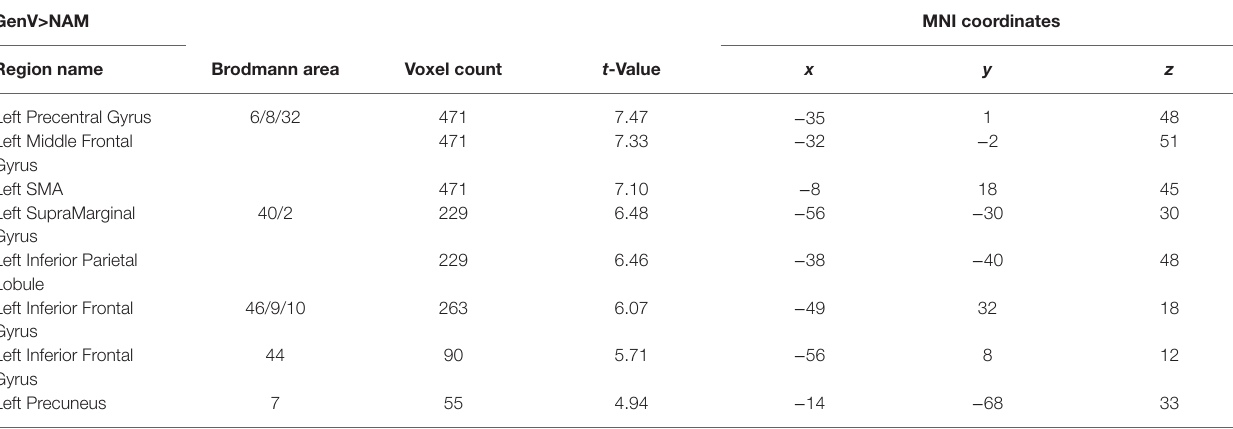
TABLE 2 | Activation peaks and extents for GenV>NAM.